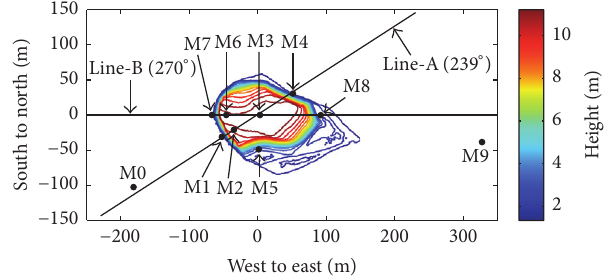
Figure 1: Bolund contour plot colored to illustrate the height. The black dots show the actual positions of masts (M0 to M9). The wind direction 270 ∘ is from west to